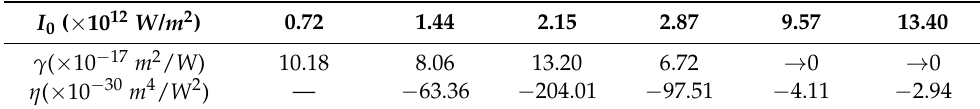
Table 1. Nonlinear refractive index of